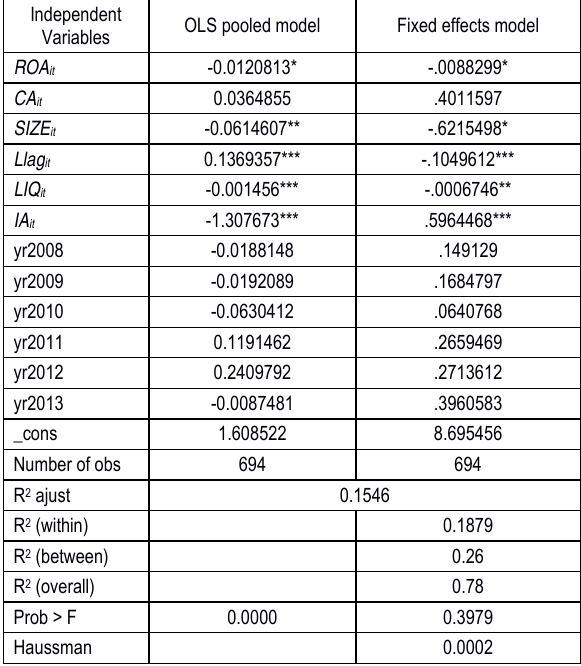
Table 12. Regression results, Model